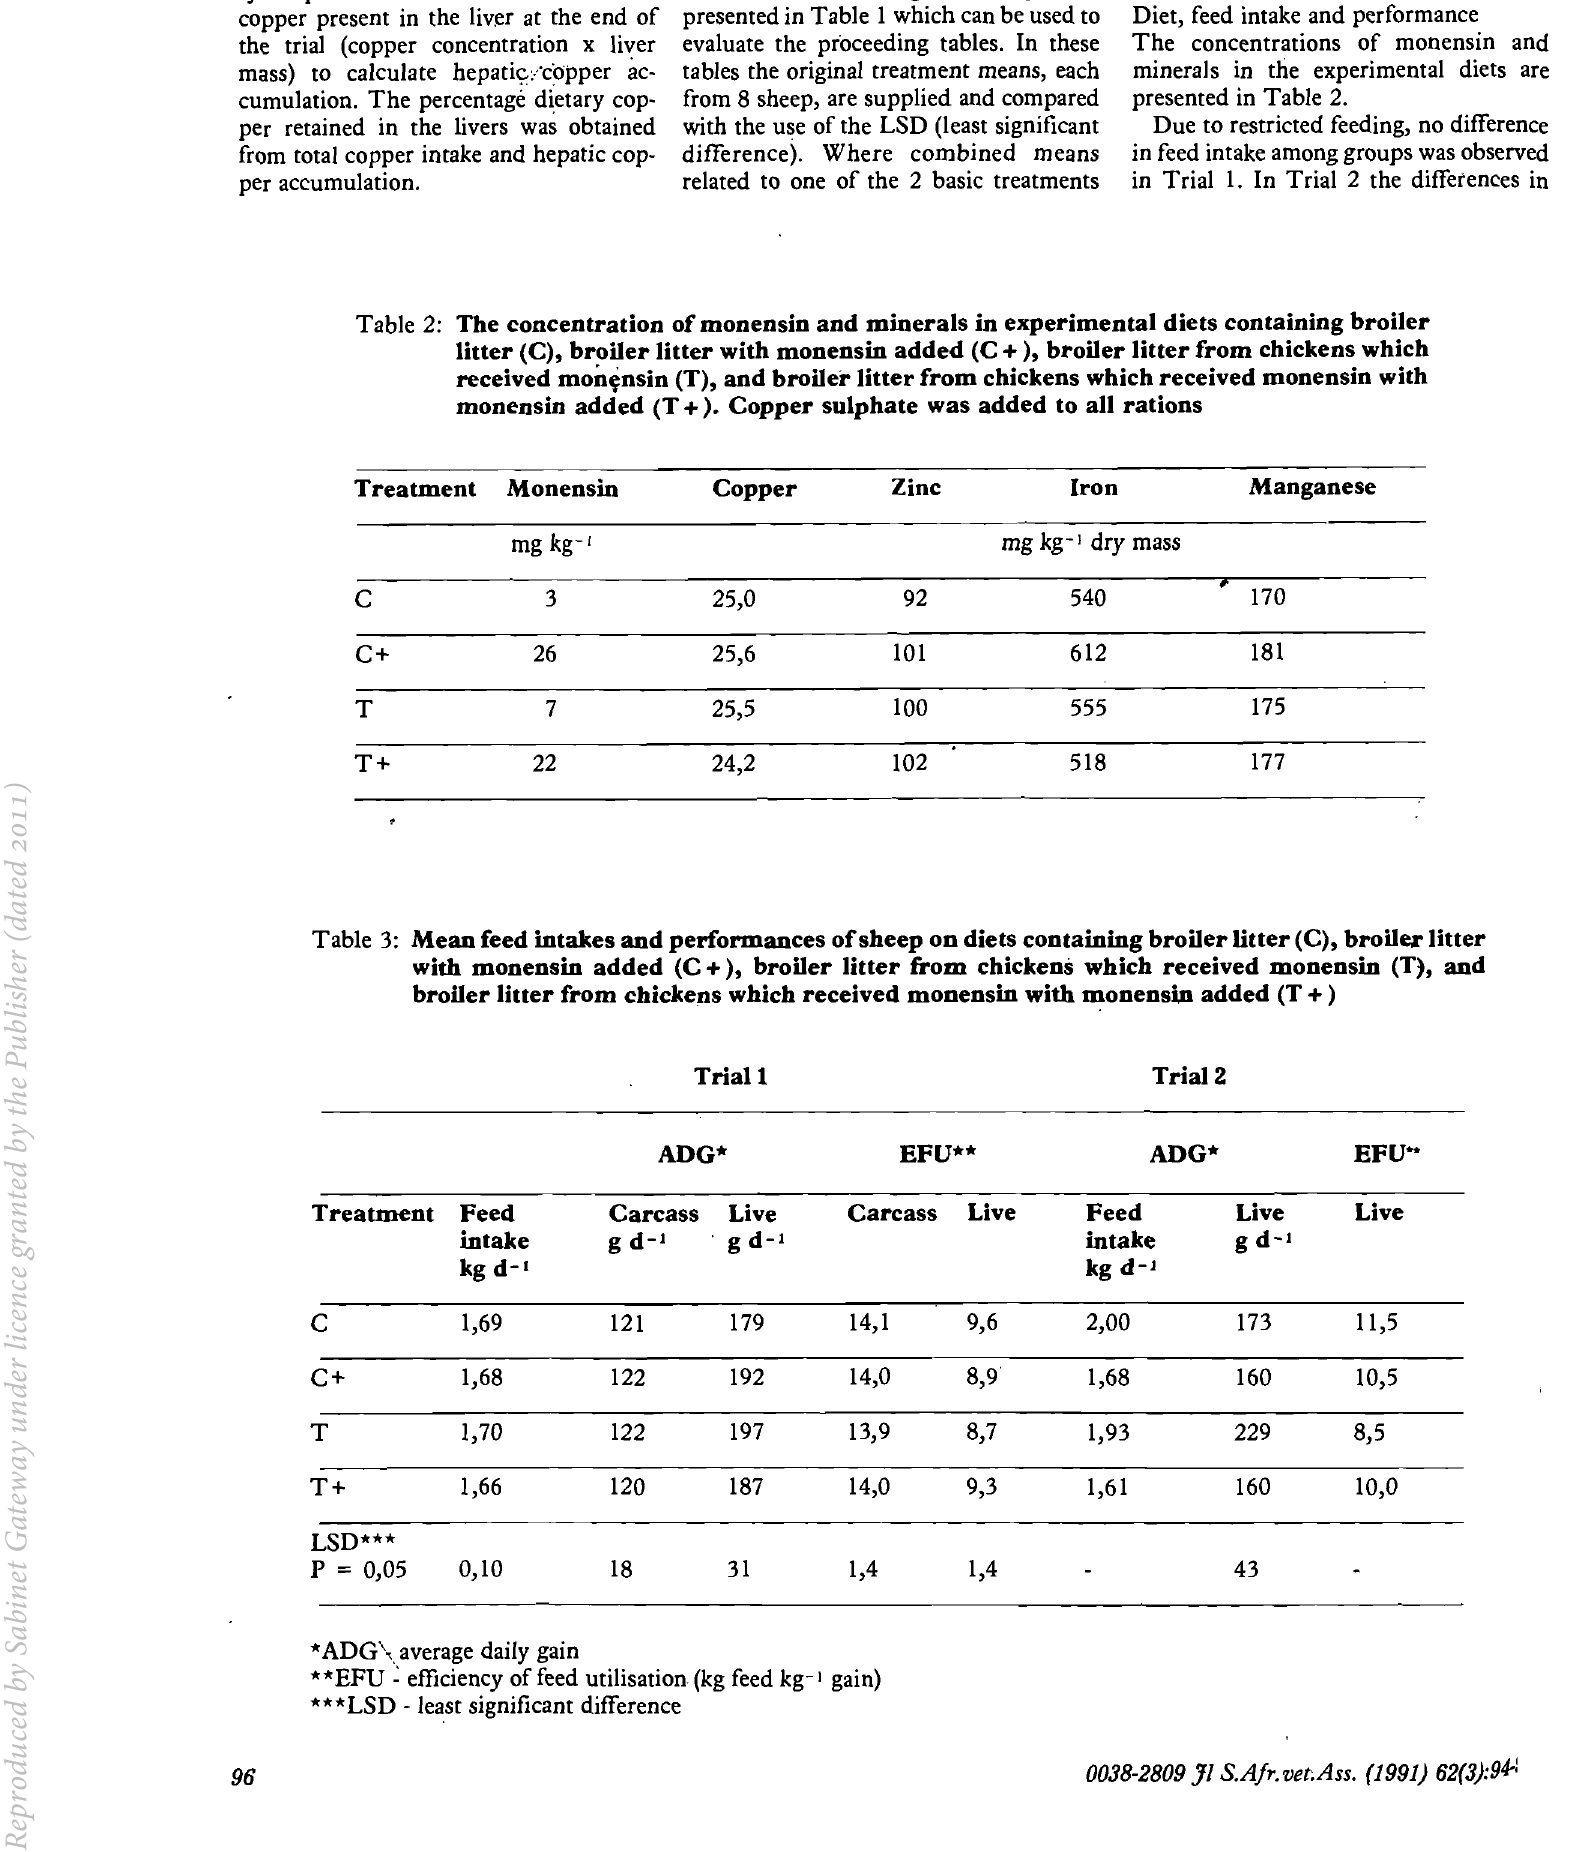
Table 3: Mean feed intakes and performances of sheep on diets containing broiler litter (C), broiler litter with monensin added (C +), broiler litter from chickens which received monensin (T), and broiler litter from chickens which received monensin with monensin added (T +